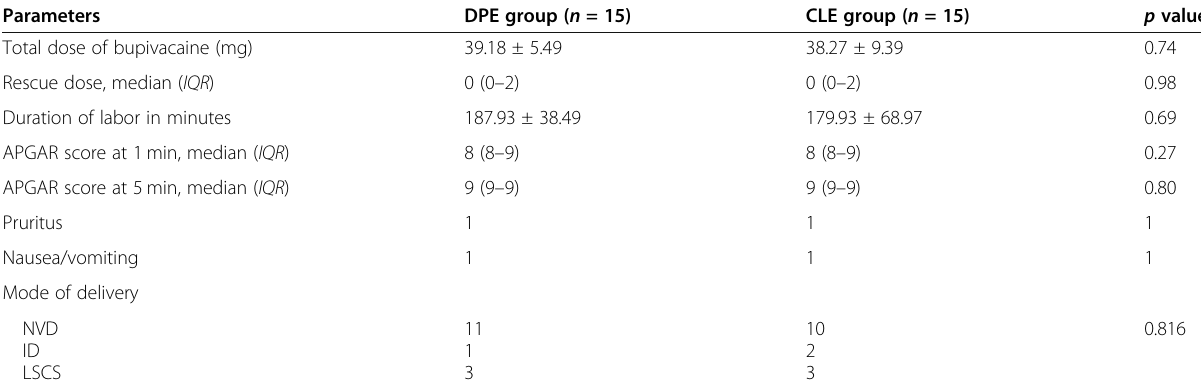
Table 2 Comparison of study groups for total bupivacaine used, rescue drug doses, duration of labor, APGAR scores, side effects, and obstetric